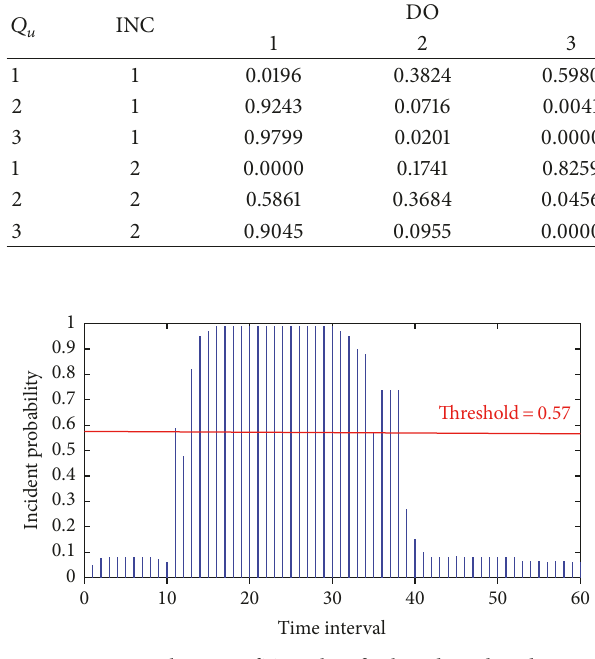
Figure4:AtypicaloutputofTANclassifierbasedincidentdetection